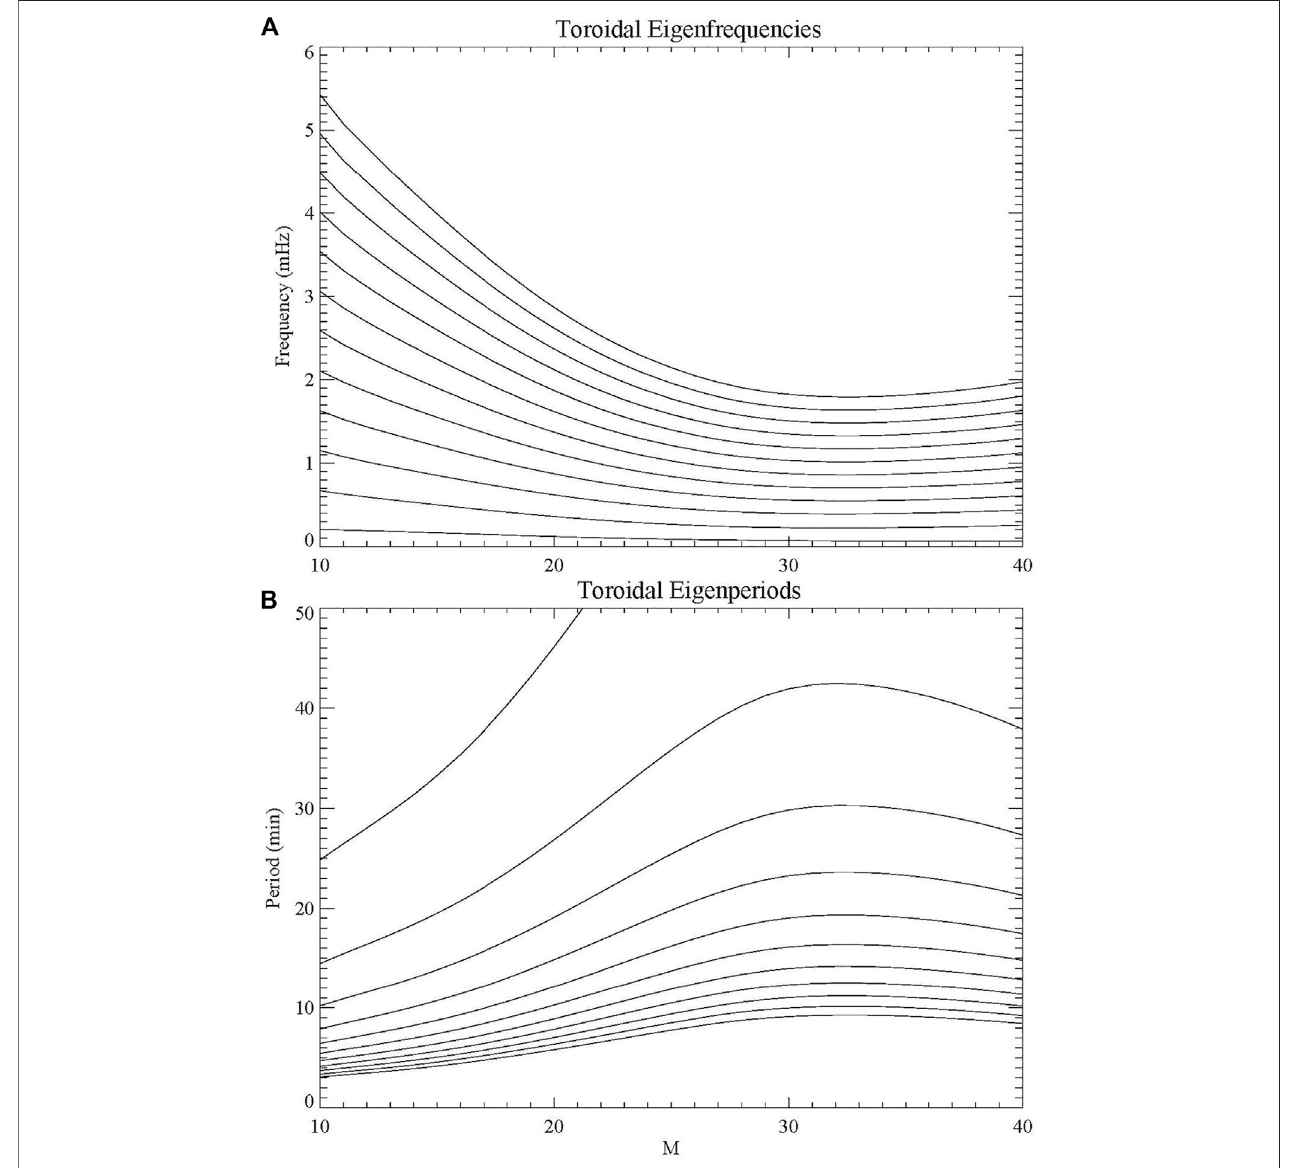
FIGURE 4 | Eigenfrequencies as a function of M-shell for fi rst 12 eigenmodes for the density and Alfvén speed given in Figure 3 . (A) Frequencies in mHz; (B) Periods in minutes. Note that the fundamental mode, which has periods greater than 80 min for all values of M, is not shown in panel b (Lysak and Song, 2020).